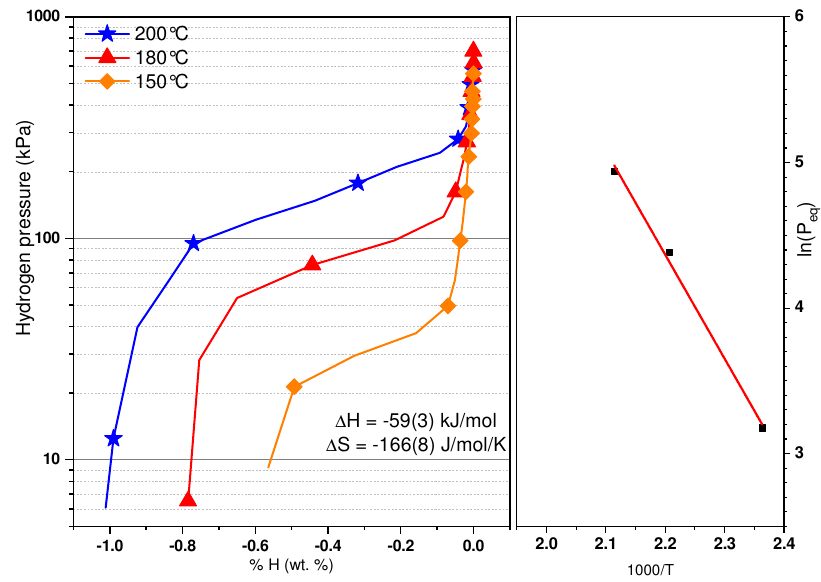
Figure 5. Desorption the Pressure Composition desorption isotherms (PCTs) at 150, 180, and 200 °C and ln (Peq) vs (1000/T) of the co-melt Ti 1.56 V 0.18 (FeV) 0.18 Cr 1.08 + 4% Zr 7 Ni 10 .